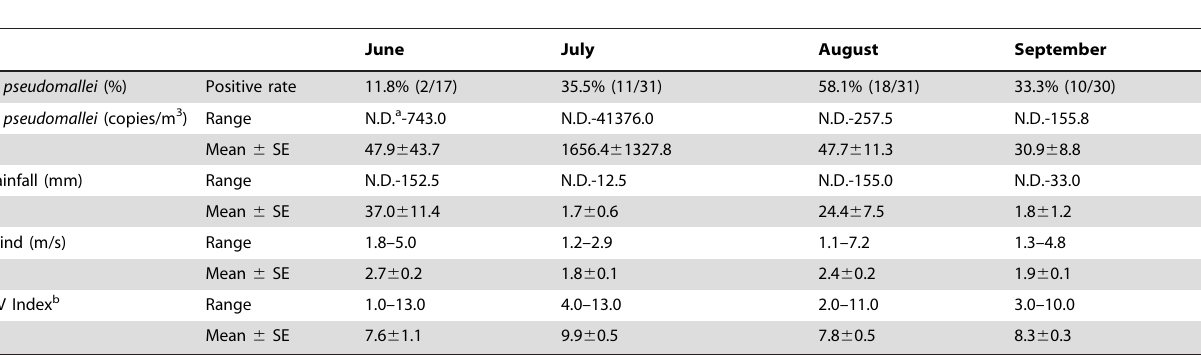
Table 3. Descriptive statistics for ambient B. pseudomallei and environmental factors in June, July, August and